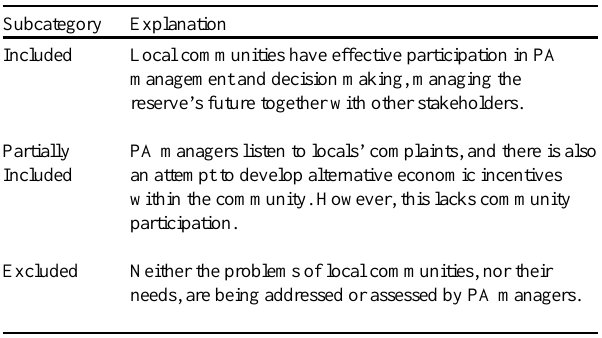
Table 3. Definitions for level of local community